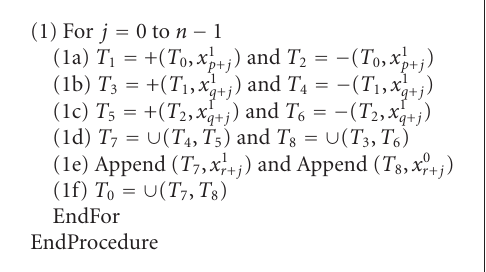
Algorithm 1: Procedure ParallelAdder ( T 0 , n , p , q , r ).